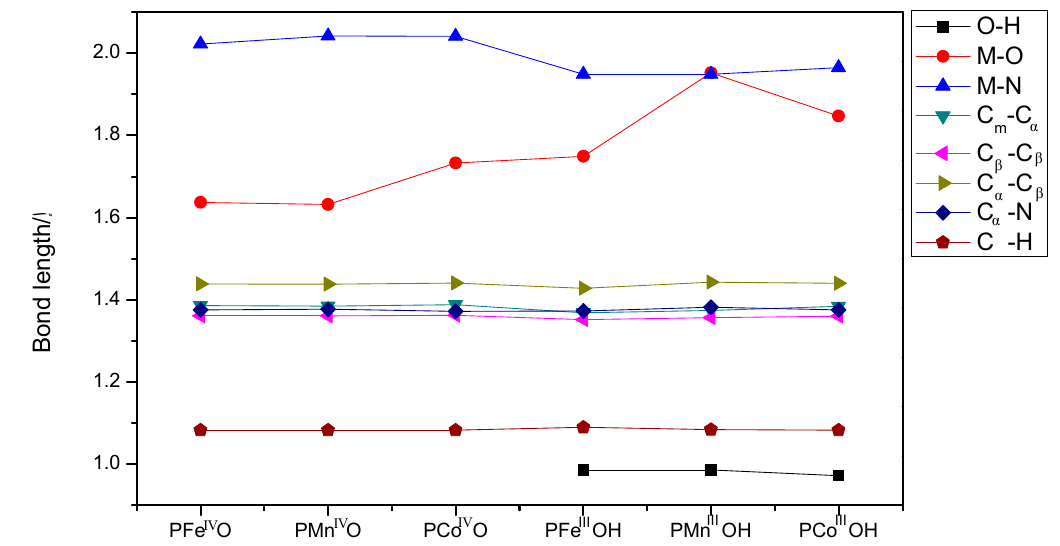
Figure 4. Calculated bond lengths of PM IV = O and PM III OH (M = Fe, Mn, and Co) intermediates.